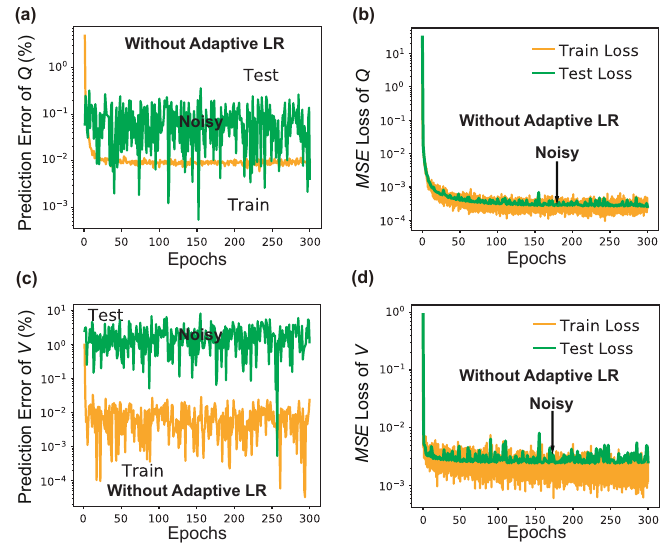
Figure 10. Results of training LRS-RCNN for L3 nanocavity when no LRS is used. The figure has the same order as Figure 8. One can observe the substantially noisier convergence curves in ( a – d ) in this case compared to